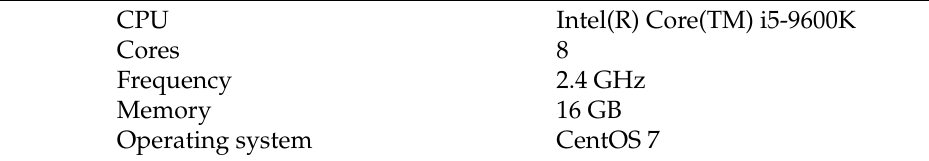
Table 2. Hardware and system